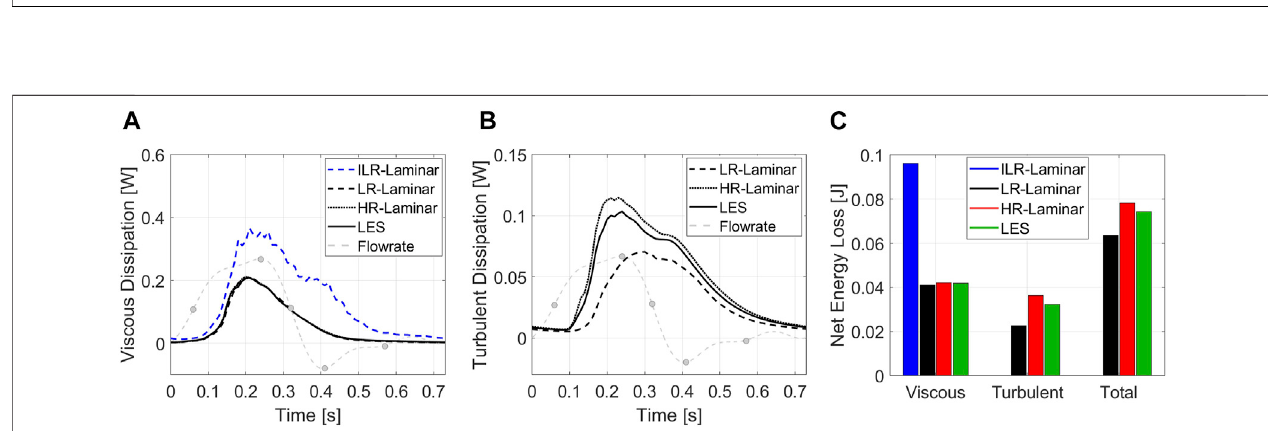
FIGURE 11 | Top row: Oscillatory shear index (OSI) contours for ILR-Laminar, LR-Laminar, HR-Laminar and LES simulations. Bottom row: Absolute difference in OSI values for ILR-, LR- and HR-Laminar simulations, relative to the LES simulation. Locations of largest differences are indicated with asterisks.